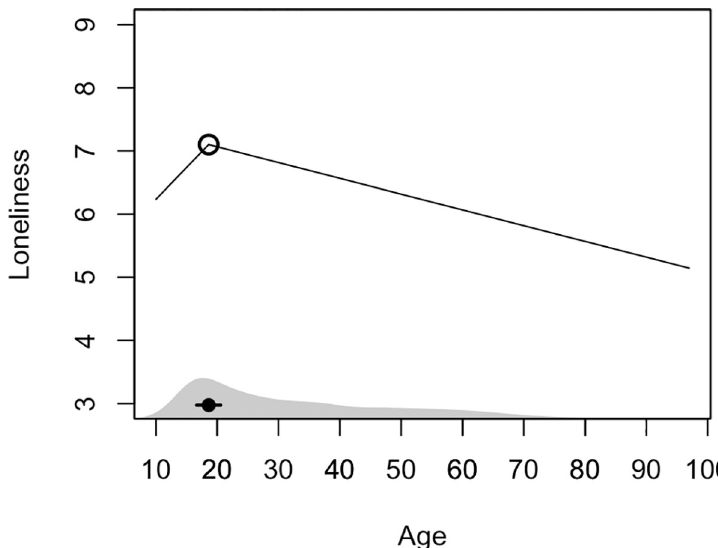
Fig 2. The relation between age and loneliness. The main black line depicts the two-segment regression solution. The black circle at the bottom of the plot represents the breakpoint—i.e., the point at which the relation between age and loneliness changes—and the horizontal lines depict the 95% CI of the breakpoint. The shaded gray region at the bottom of the plot is a rug plot of the age distribution.